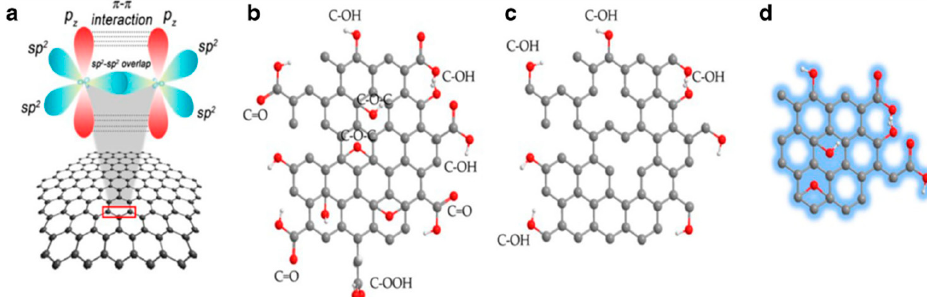
Figure 6. Structure of ( a ) GR, ( b ) GO, ( c ) rGO and ( d ) GQDs. Reprinted with permission from Ref. [99]. Copyright 2021, the Springer Nature.